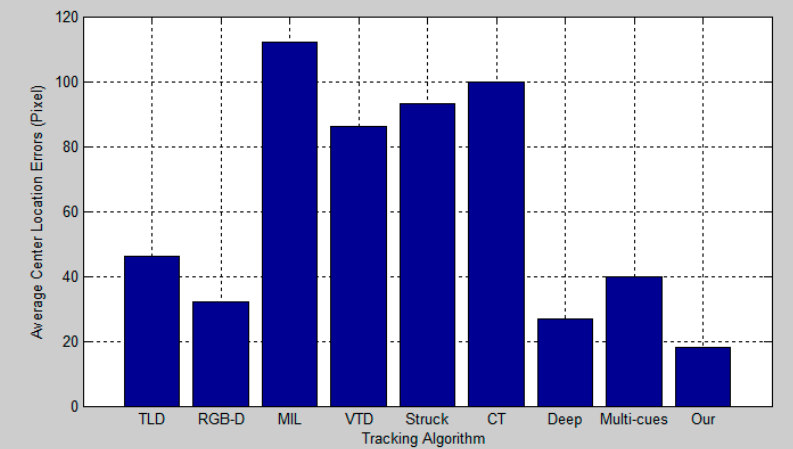
Figure 12. Quantitative evaluation in terms of average center location error (in pixel) for the first experiment.